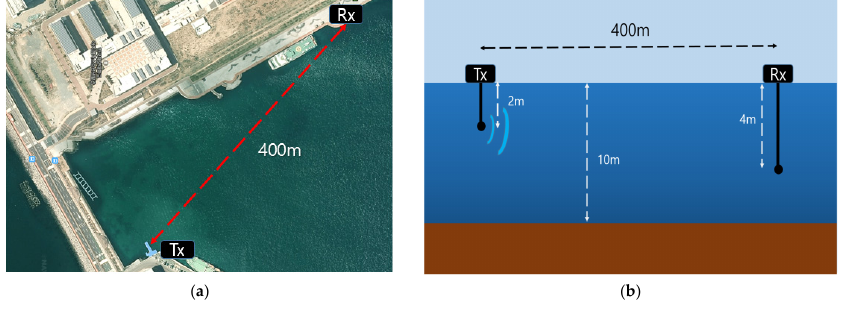
Figure 14. ( a ) Layout diagram of experimental area, ( b ) Experimental setup. Table 3. Parameters of sea trials.